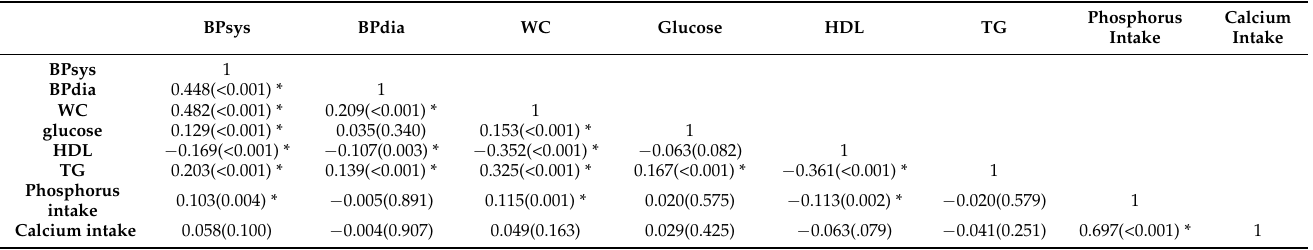
Table 3. Correlation for BP, WC, Glucose, TG, HDL and daily phosphorus intake (N = 893).